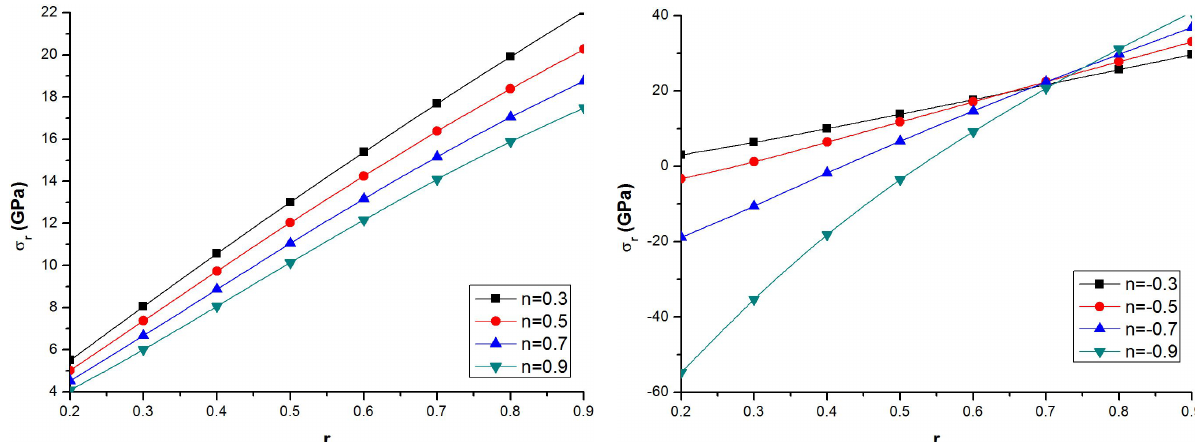
Figure 3: Variation in radial stress against radial coordinate for different values of n